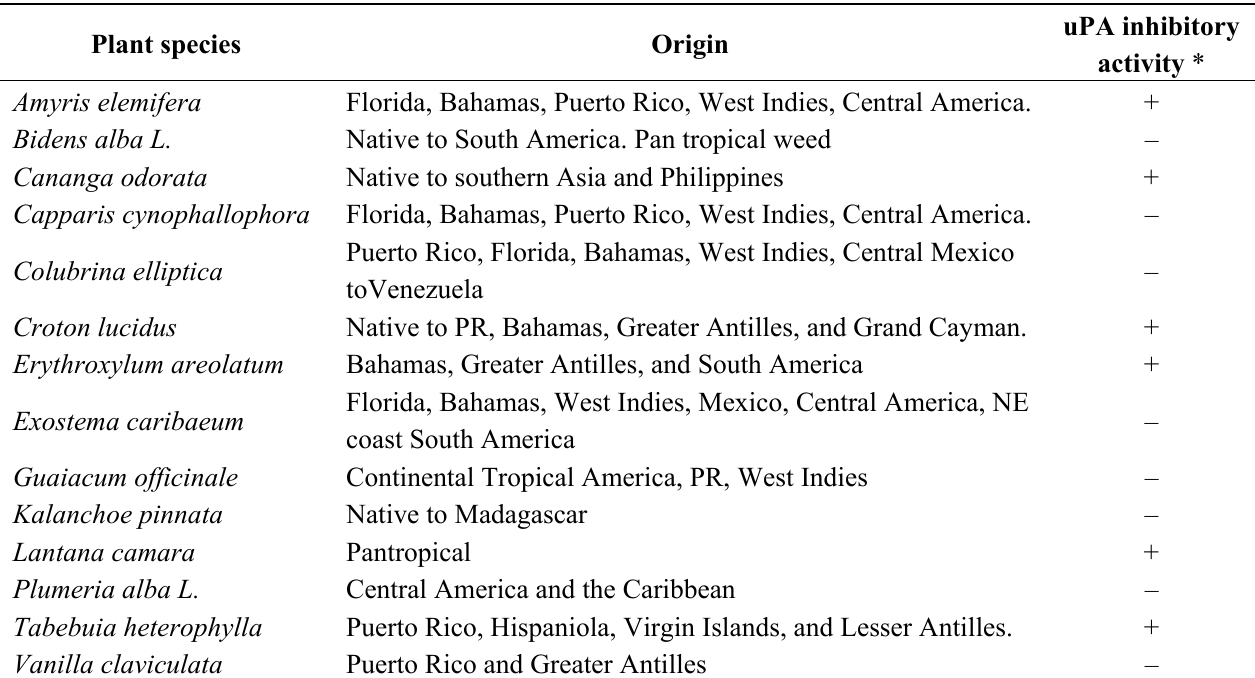
Table 1. Screening of plant extracts for inhibition of